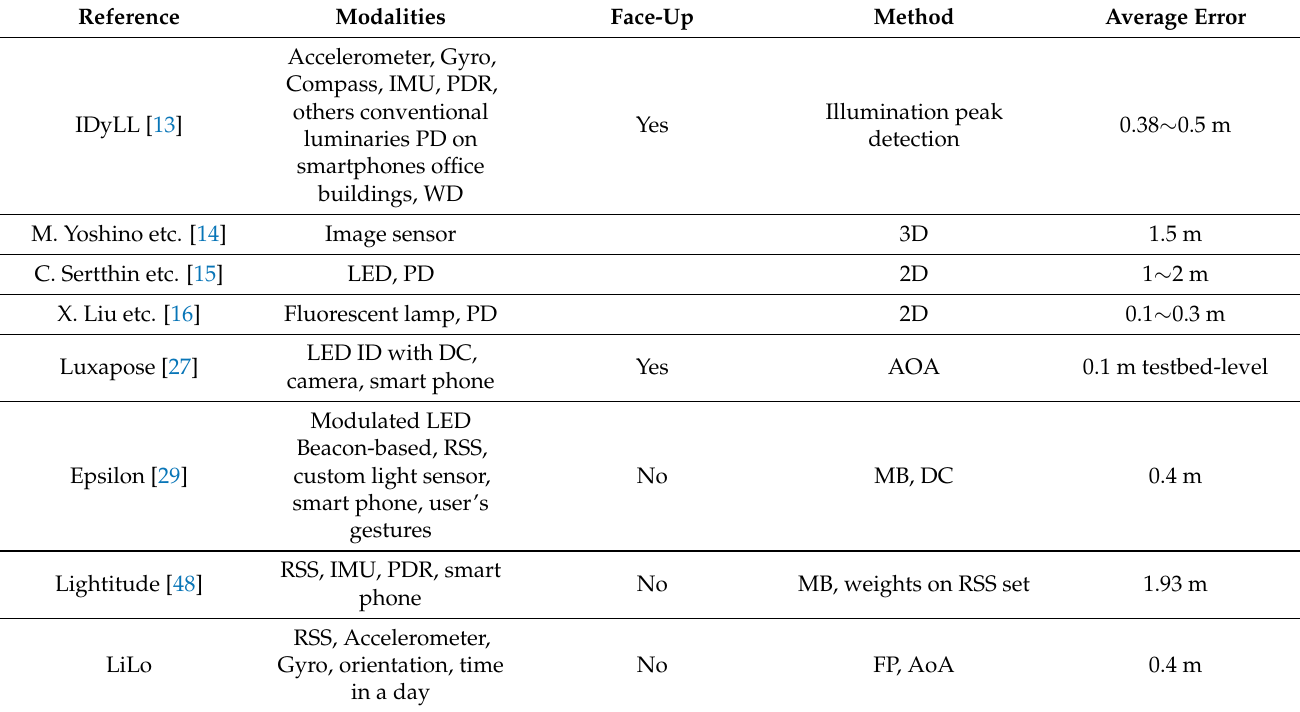
Table 3. Comparison of recognition accuracy to previous